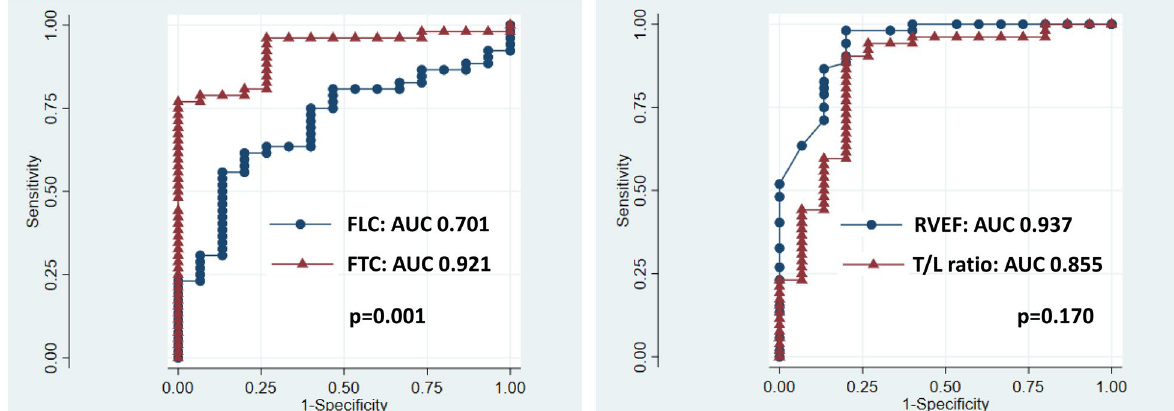
Figure 7. ROC curve for “Degenerated RV” detection. The left side: ROC curve for FLC and FTC. The right side: ROC curve for T/L ratio and RVEF. Figures indicate AUC for the parameters. p value indicate the probability of the null hypothesis in testing the equivalence of ROC curves. ROC Receiver operating characteristic, AUC Area under the curve, RVEF Right ventricular ejection fraction, FLC Fractional longitudinal change, FTC Fractional transverse